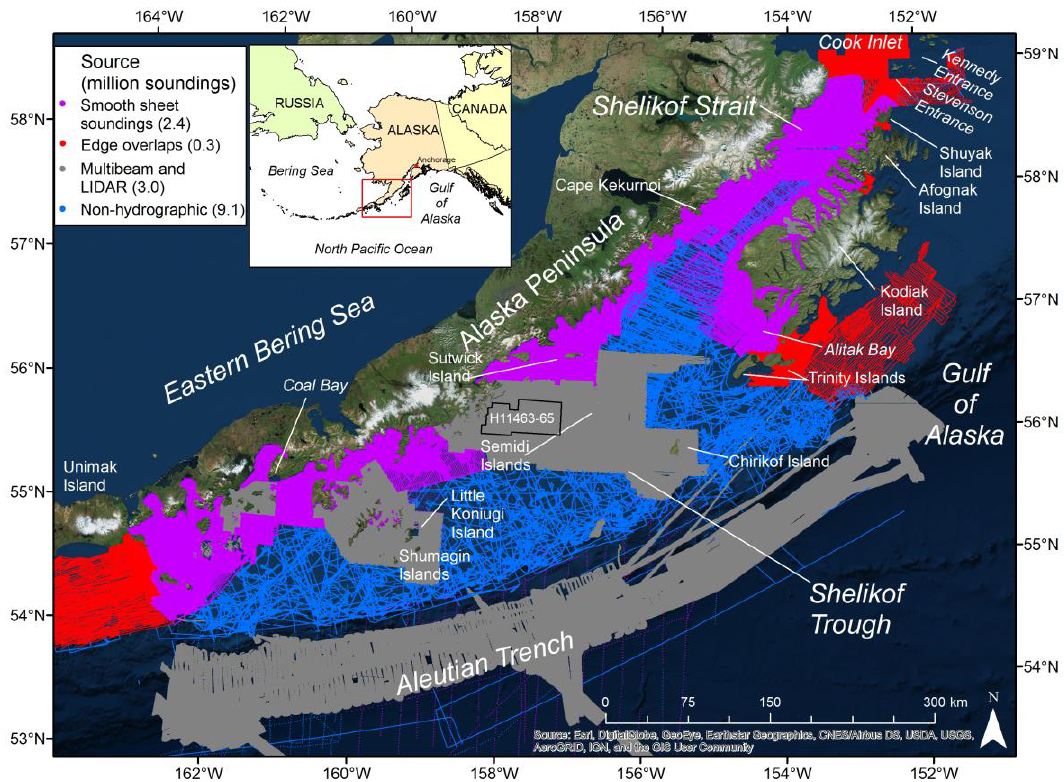
Figure 2. Sources of bathymetry data used in this western Gulf of Alaska compilation. Edge overlaps are repeated data sets from previously published bathymetry maps bordering this area. Non-hydrographic surveys are non-calibrated singlebeam surveys.